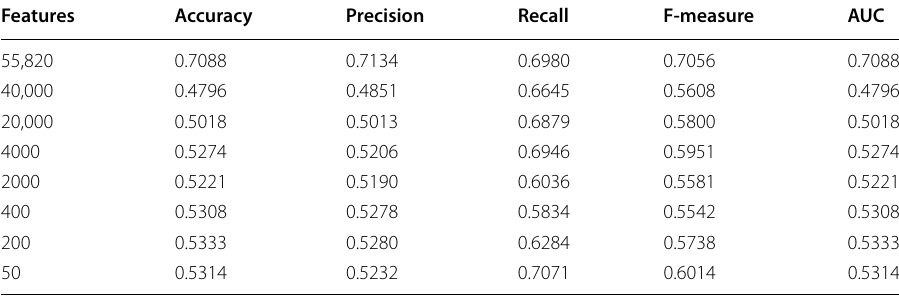
Table 2 Performance of the Chi-squared feature selection on the StockTwits dataset